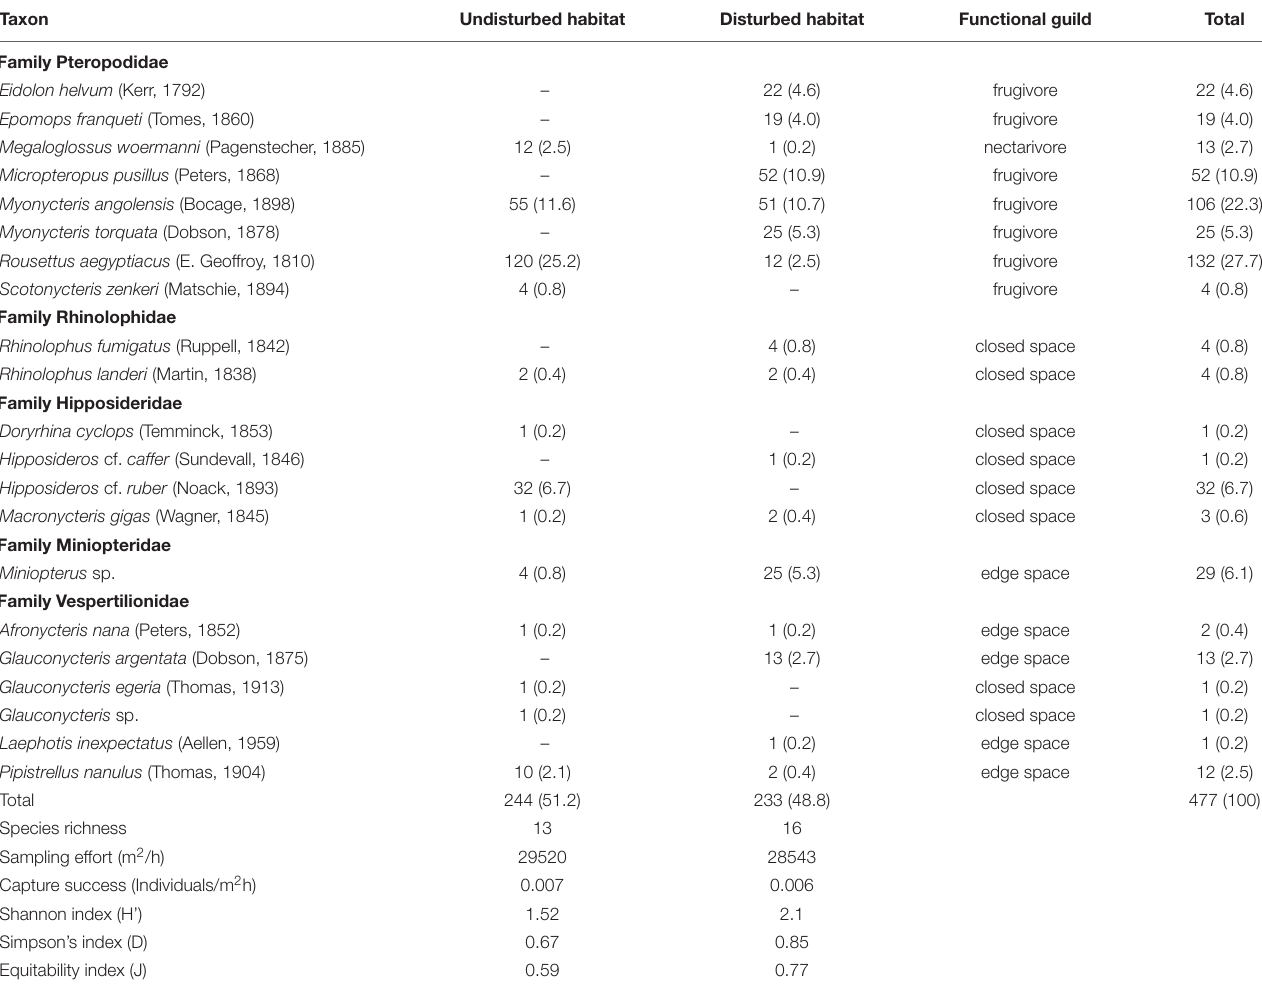
TABLE 1 | Number of individuals, species richness, functional guild, sampling effort, capture success and relative abundances in parentheses of bats captured in undisturbed and disturbed habitat sites of the Afromontane forest biome of western Cameroon from June 2019 to March